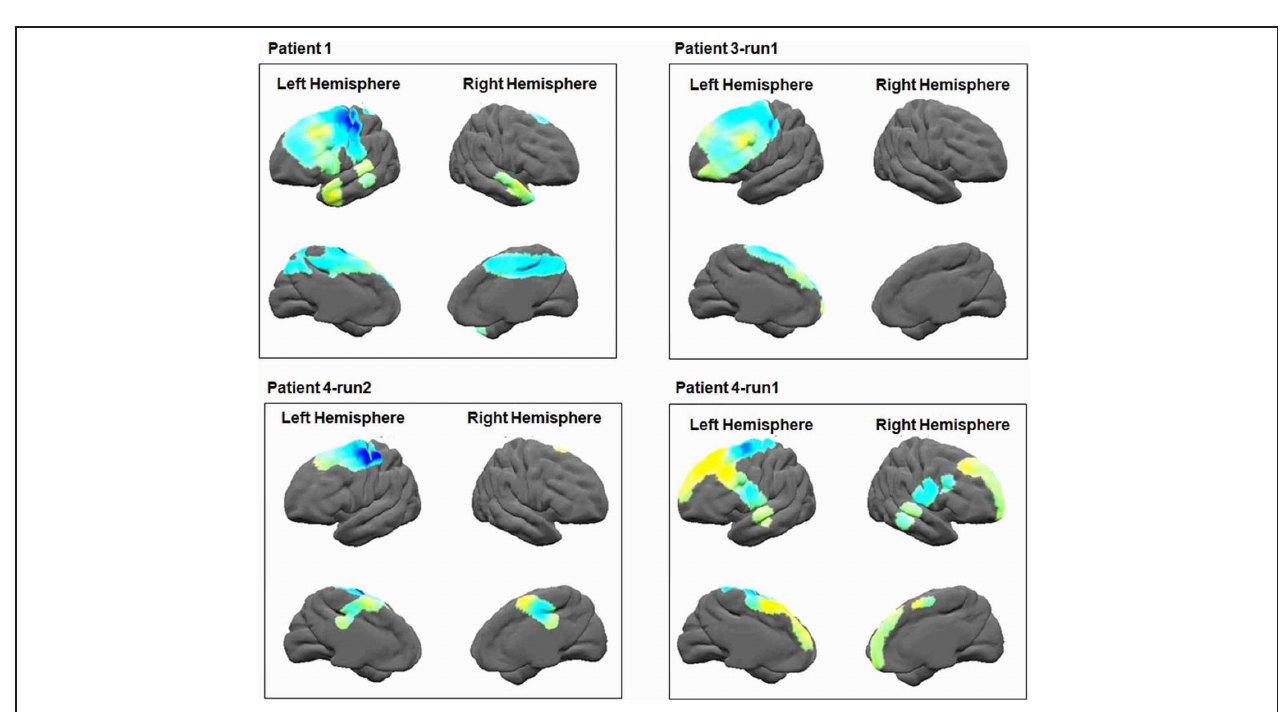
FIGURE 7 | Alpha brain power plots. The results of time frequency analysis, averaged across the alpha band (8–12Hz), show alpha de-synchronization in the primary motor area.